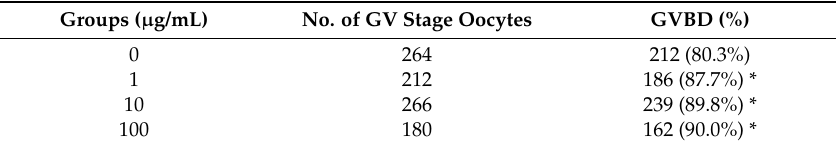
Table 1. Effect of fullerenol on oocyte germinal vesicle breakdown (GVBD). Groups ( μ g/mL)